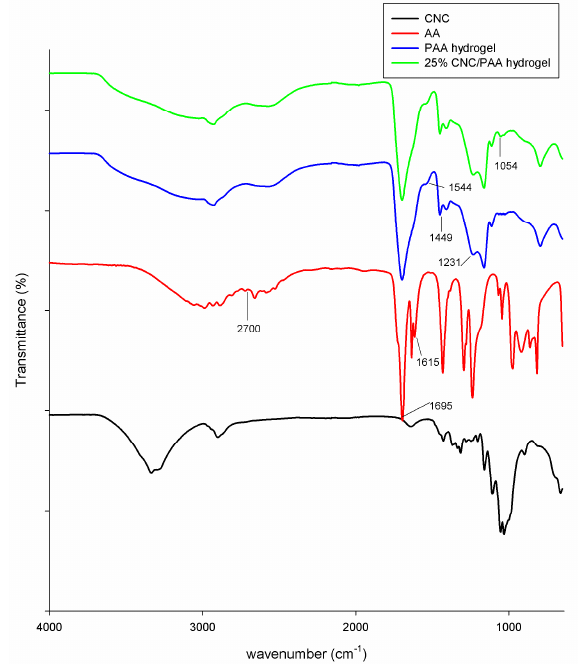
Figure 1. FTIR (Fourier Transform Infrared) spectra of CNC, AA, PAA hydrogel, and 25% CNC/PAA Figure hydrogel.